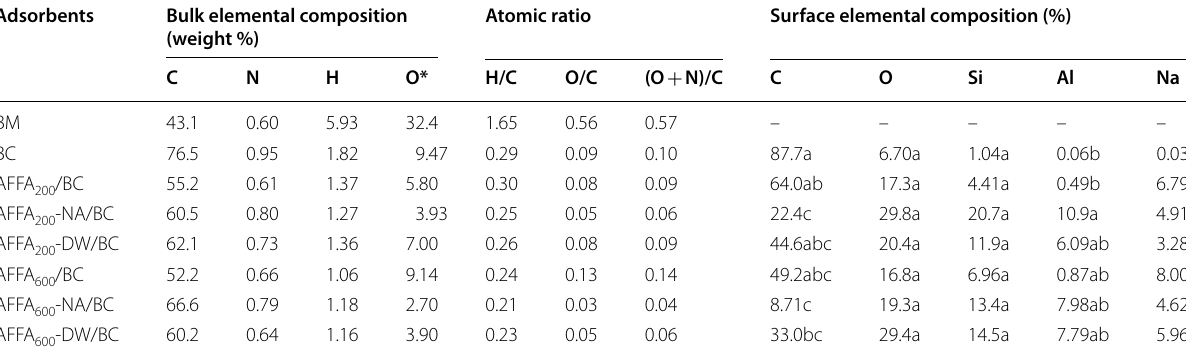
*Obtained by % O = 100% − ( % C + % N + % H + % S + %ash ) Different letters indicate significant difference for the results in the same column